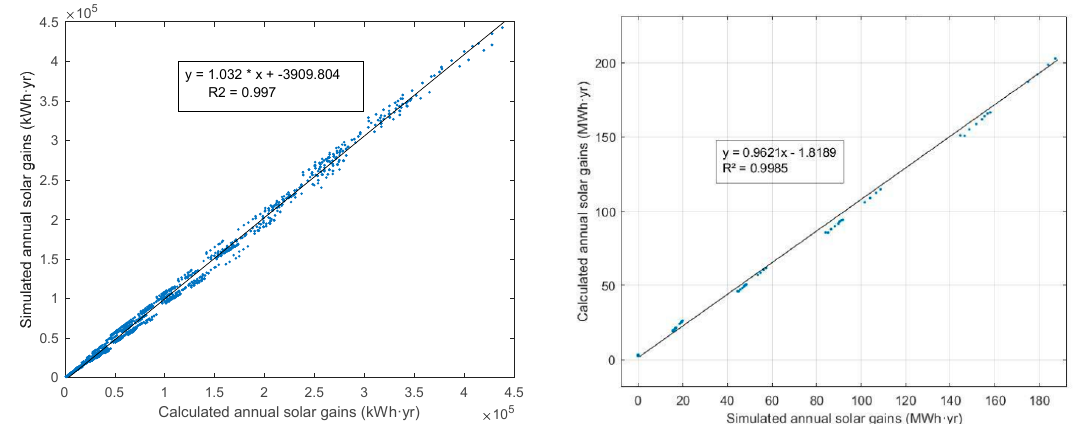
Figure 12. Calculated annual solar heat gains correlation to simulated annual solar heat gains. On the left the model training data and on the right the validation.